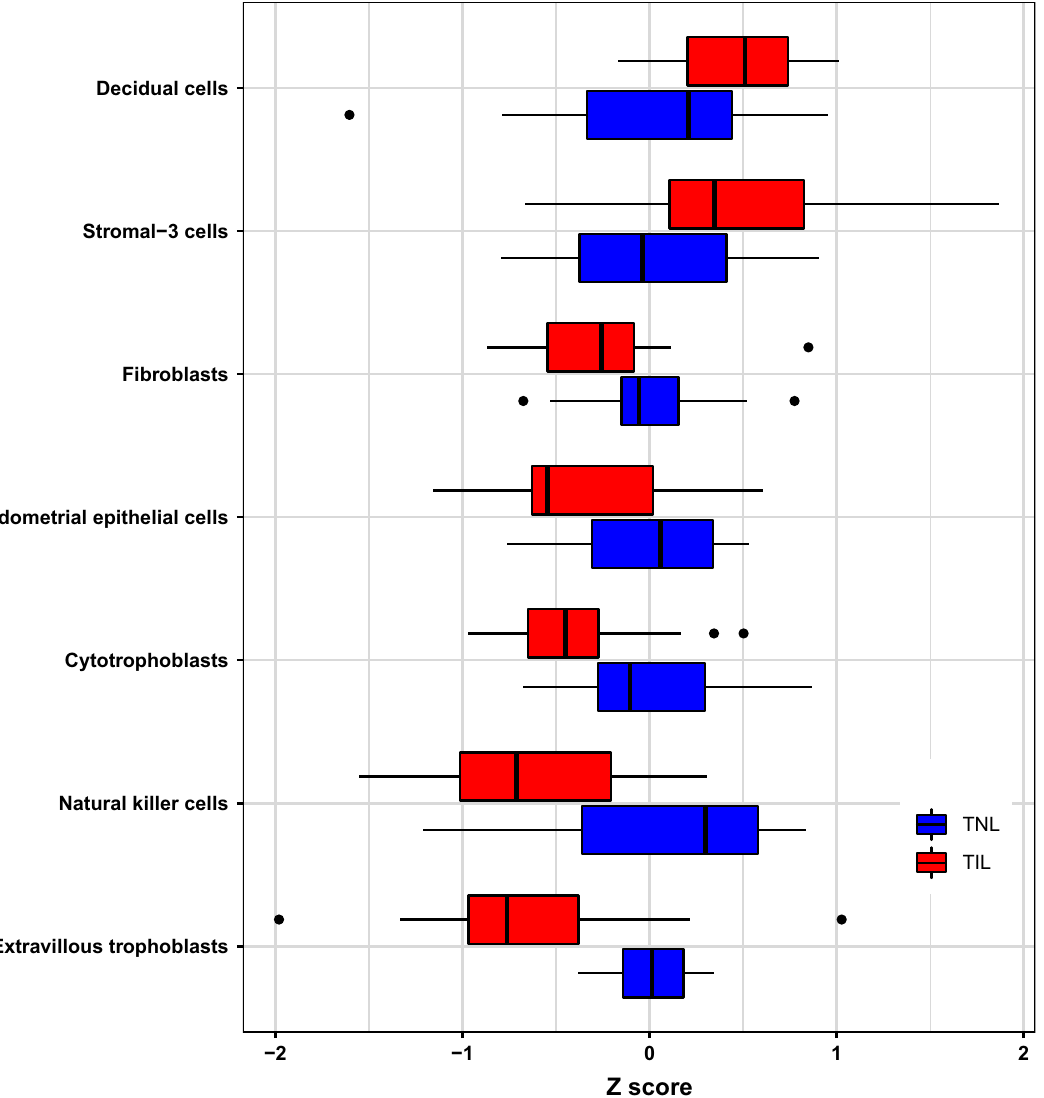
Figure 5. Placental single-cell RNA-seq signatures represented within the amniotic fluid proteome. For each placental cell type signature previously derived by single-cell RNA-seq analysis, the concentration of proteins coded by up to 20 most preferentially expressed genes was transformed into a Z-score and averaged. The Z-scores were compared between the term not in labor (TNL, blue bars) and term in labor (TIL, red bars) groups. The cell types that significantly (q-value < 0.1) changed in expression are shown. The box plots were generated with the R package, ggplot2 159